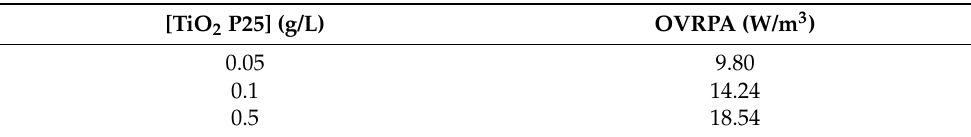
Table 1. OVRPA values for the photocatalytic experiments.